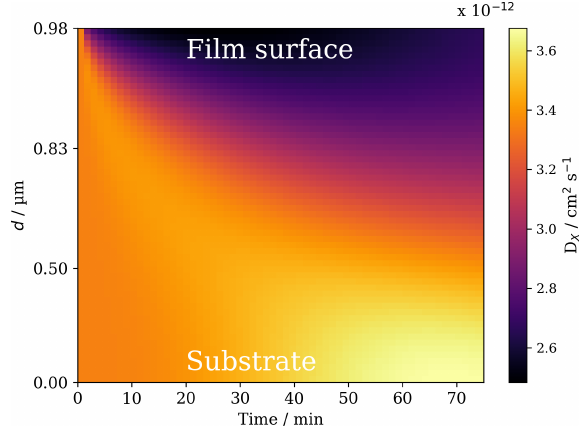
Figure 5. The evolution of ozone diffusivity throughout a 0.98µm film during ozonolysis. [ O 3 ] = 77ppm. d : the distance from the film–substrate